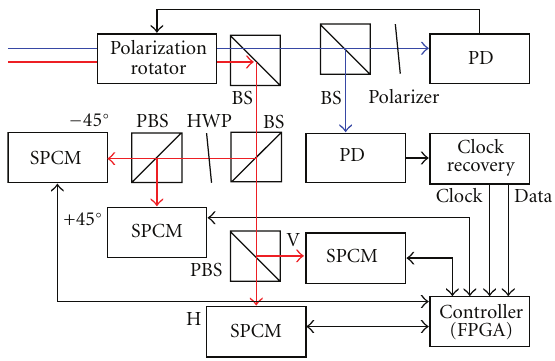
Figure 7: Configuration of receiver (Bob).